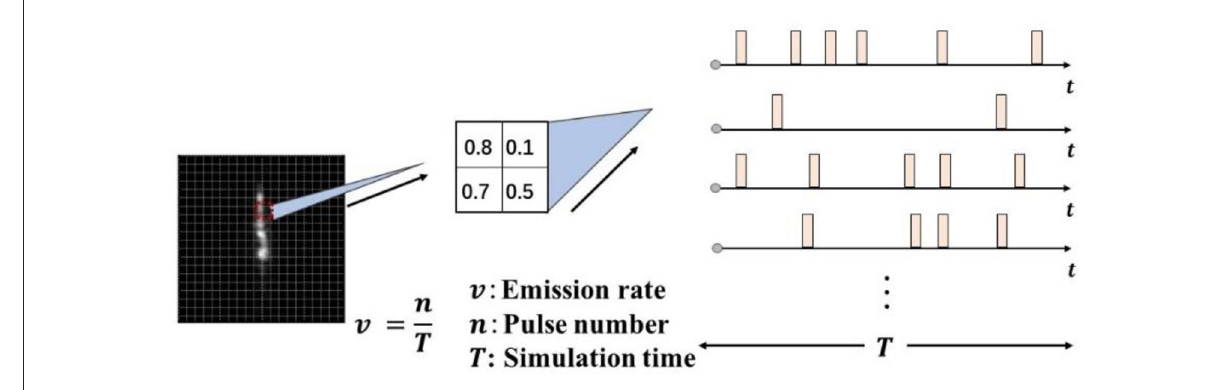
FIGURE3 Schematic diagram of Poisson encoding